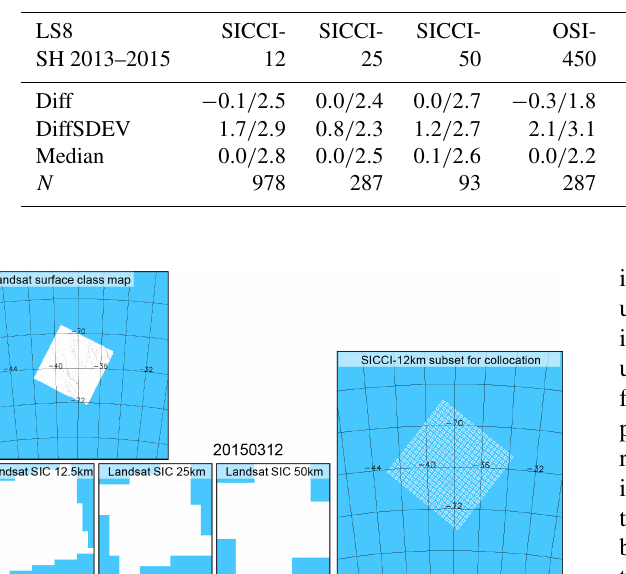
Table 11. Summary of statistical results obtained for the four high-concentration cases in the Southern Hemisphere. See Table 5 for an explanation of the parameters shown. For SICCI-2 and OSI-450 products, we include in rows “Diff”, “DiffSDEV”, and “Median” values obtained using non-truncated SIC to the right of the “/”.